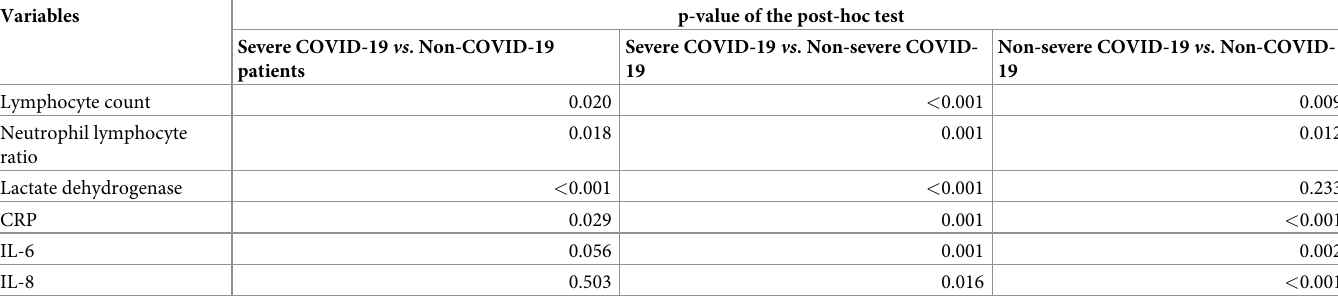
Table 3. A post-hoc test of the significant laboratory findings.